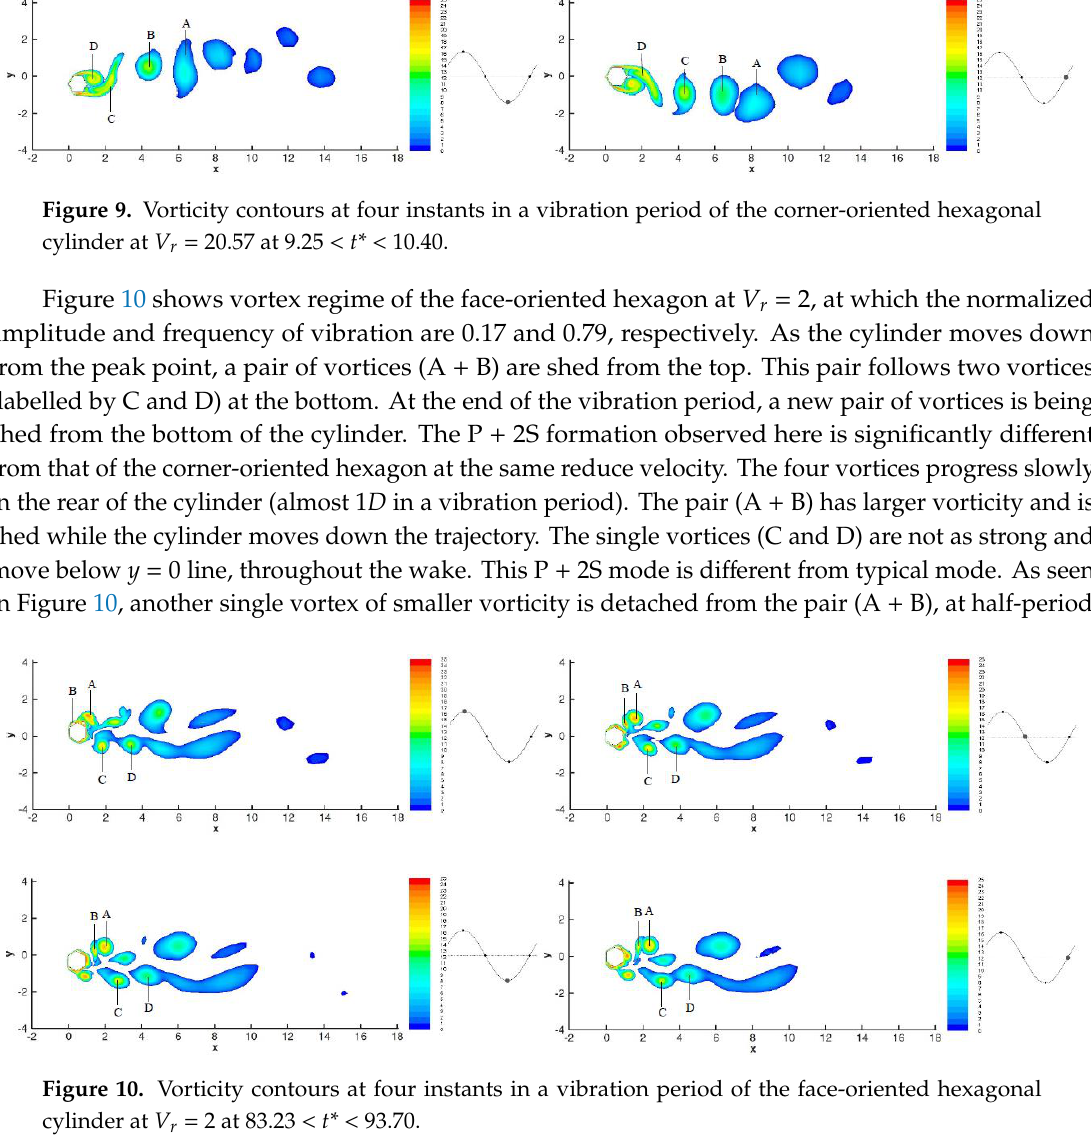
Figure 8. Vorticity contours at four instants in a vibration period of the corner-oriented hexagonal cylinder at Vr = 11.41 at 18.18 < t* < 19.51.